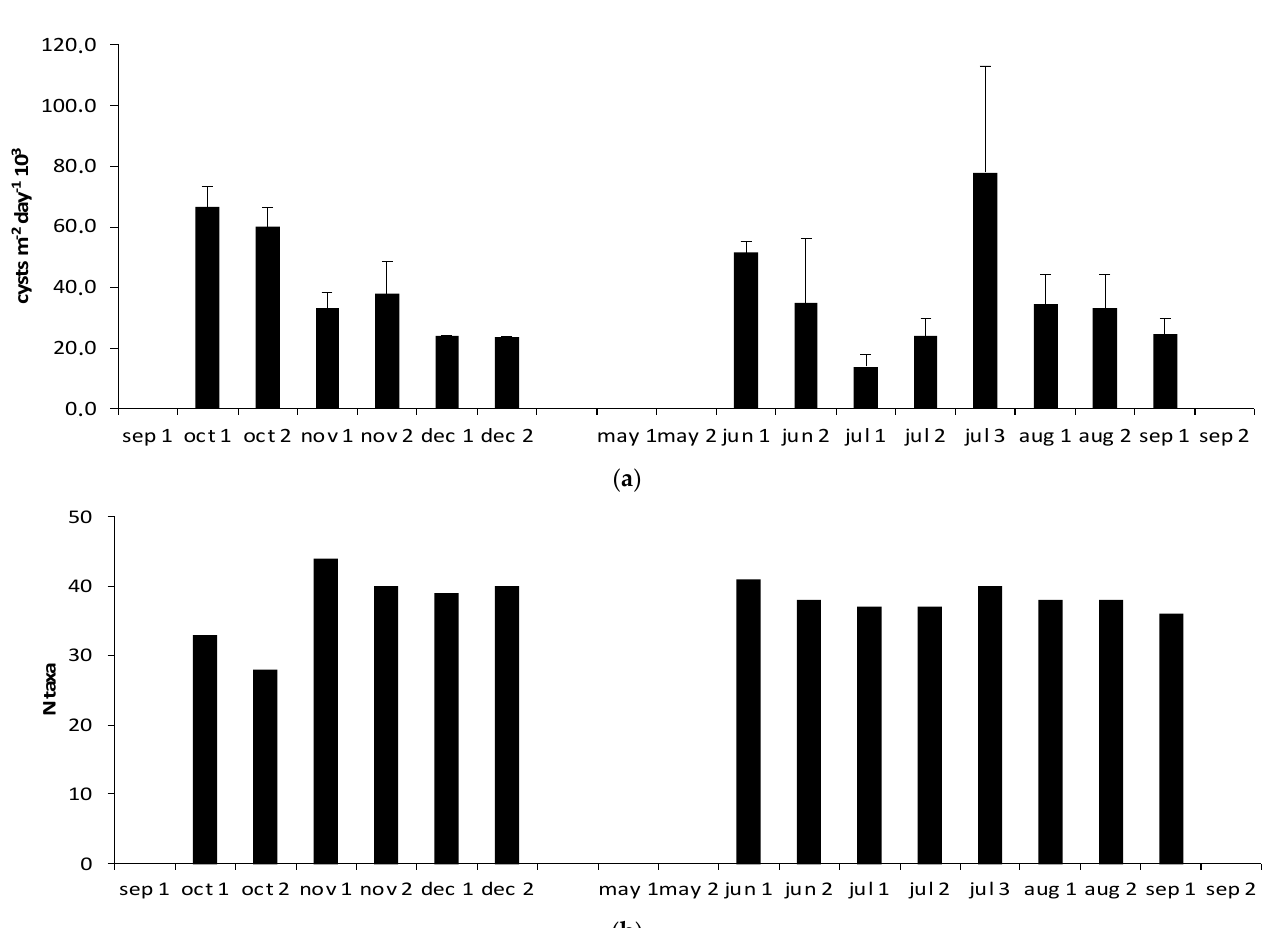
Figure 6. Cysts in the sediment traps of the Mar Piccolo of Taranto. The daily rates of cysts sunk in traps derived by an exposition of 15 days consecutively (at each sampling date). ( a ) Total daily sink rates (average ± SD); ( b ) taxa richness. Tintinnopsis sp. (Ciliophora) was observed only on 2 November (T1), together